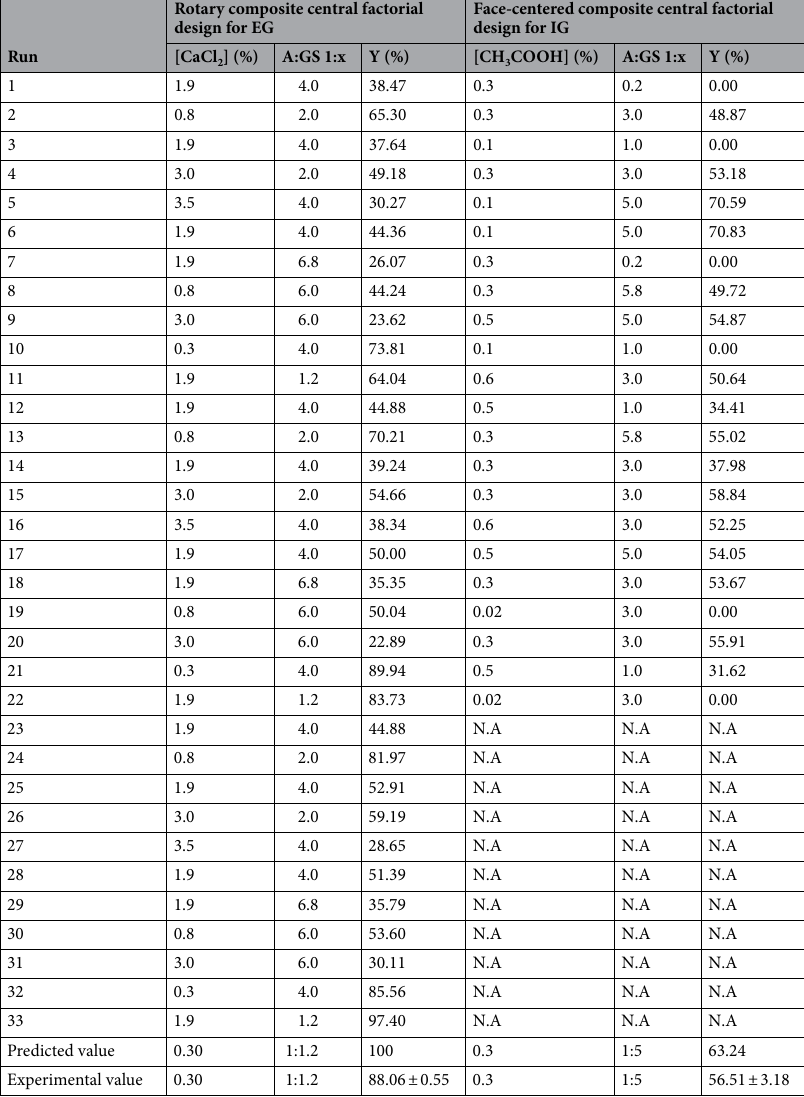
Table 1. Experimental design matrix for optimization of yield. [CaCl 2 ] (%) calcium chloride concentration, A:GS (1:X) alginate: gelling solution ratio, [CH 33 COOH] (%) acetic acid concentration, Y (%) process yield percentage.